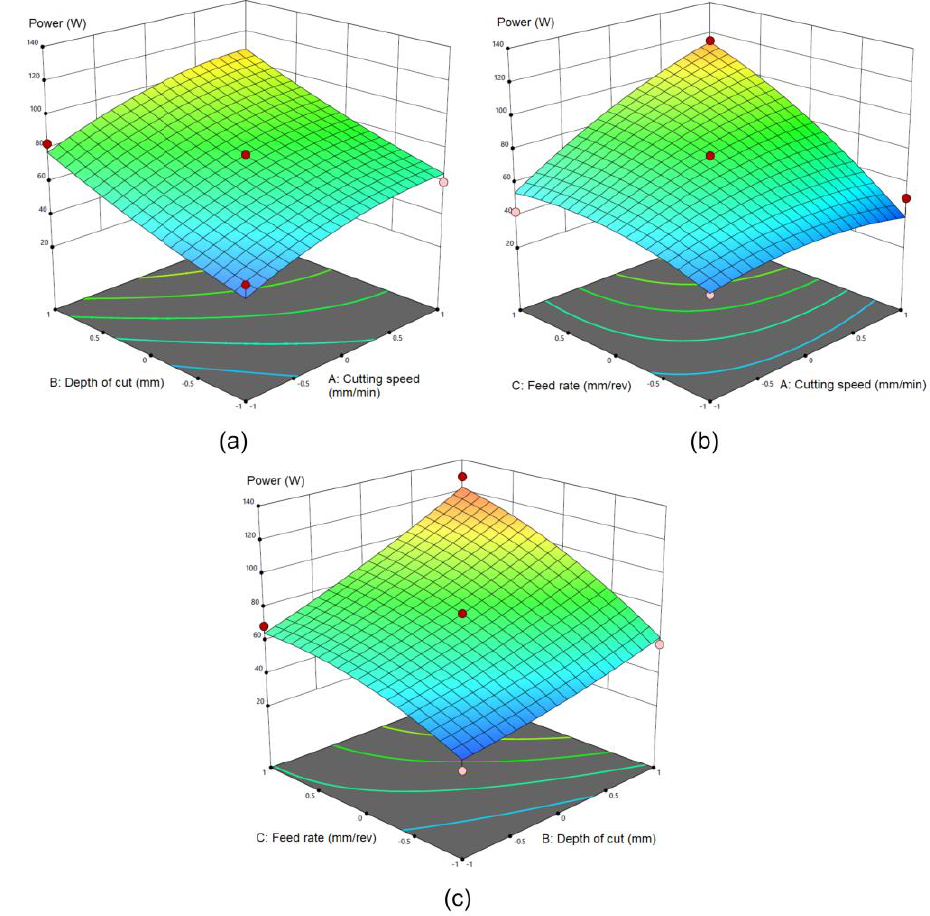
Figure 8. The effects of the parameters affecting the turning of the AISI 52100 bearing steel material on the power consumption variables: ( a ) depth of cut-cutting speed; ( b ) feed rate-cutting speed; ( c ) feed rate-depth of cut.